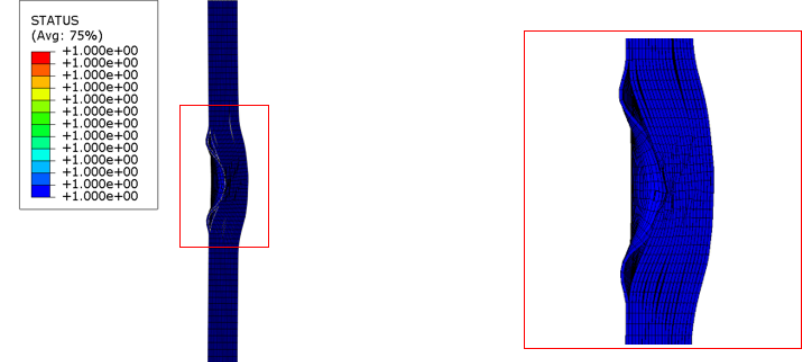
Figure 6: Interlaminar damage (delamination)